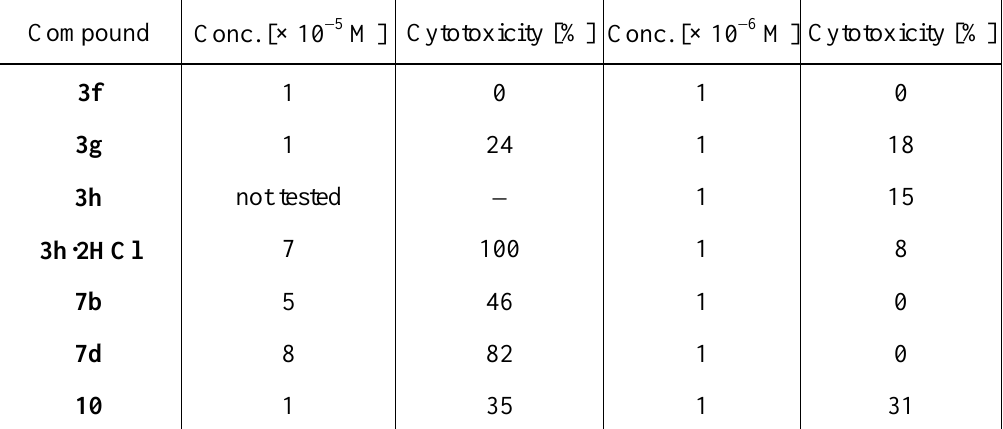
Table 2. Cytotoxic activities of compounds 3f − h , 3h·2HCl , 7b , d and 10 .